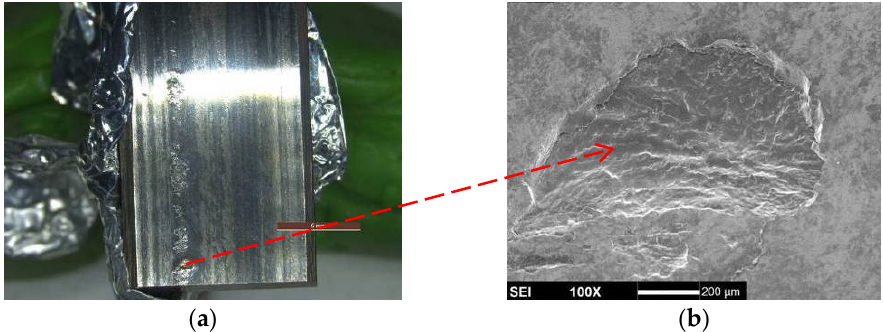
Figure 6. Intermittent distributed spalling pits of the outer ring raceway: ( a ) macroscopic damage; ( b ) microscopic damage.